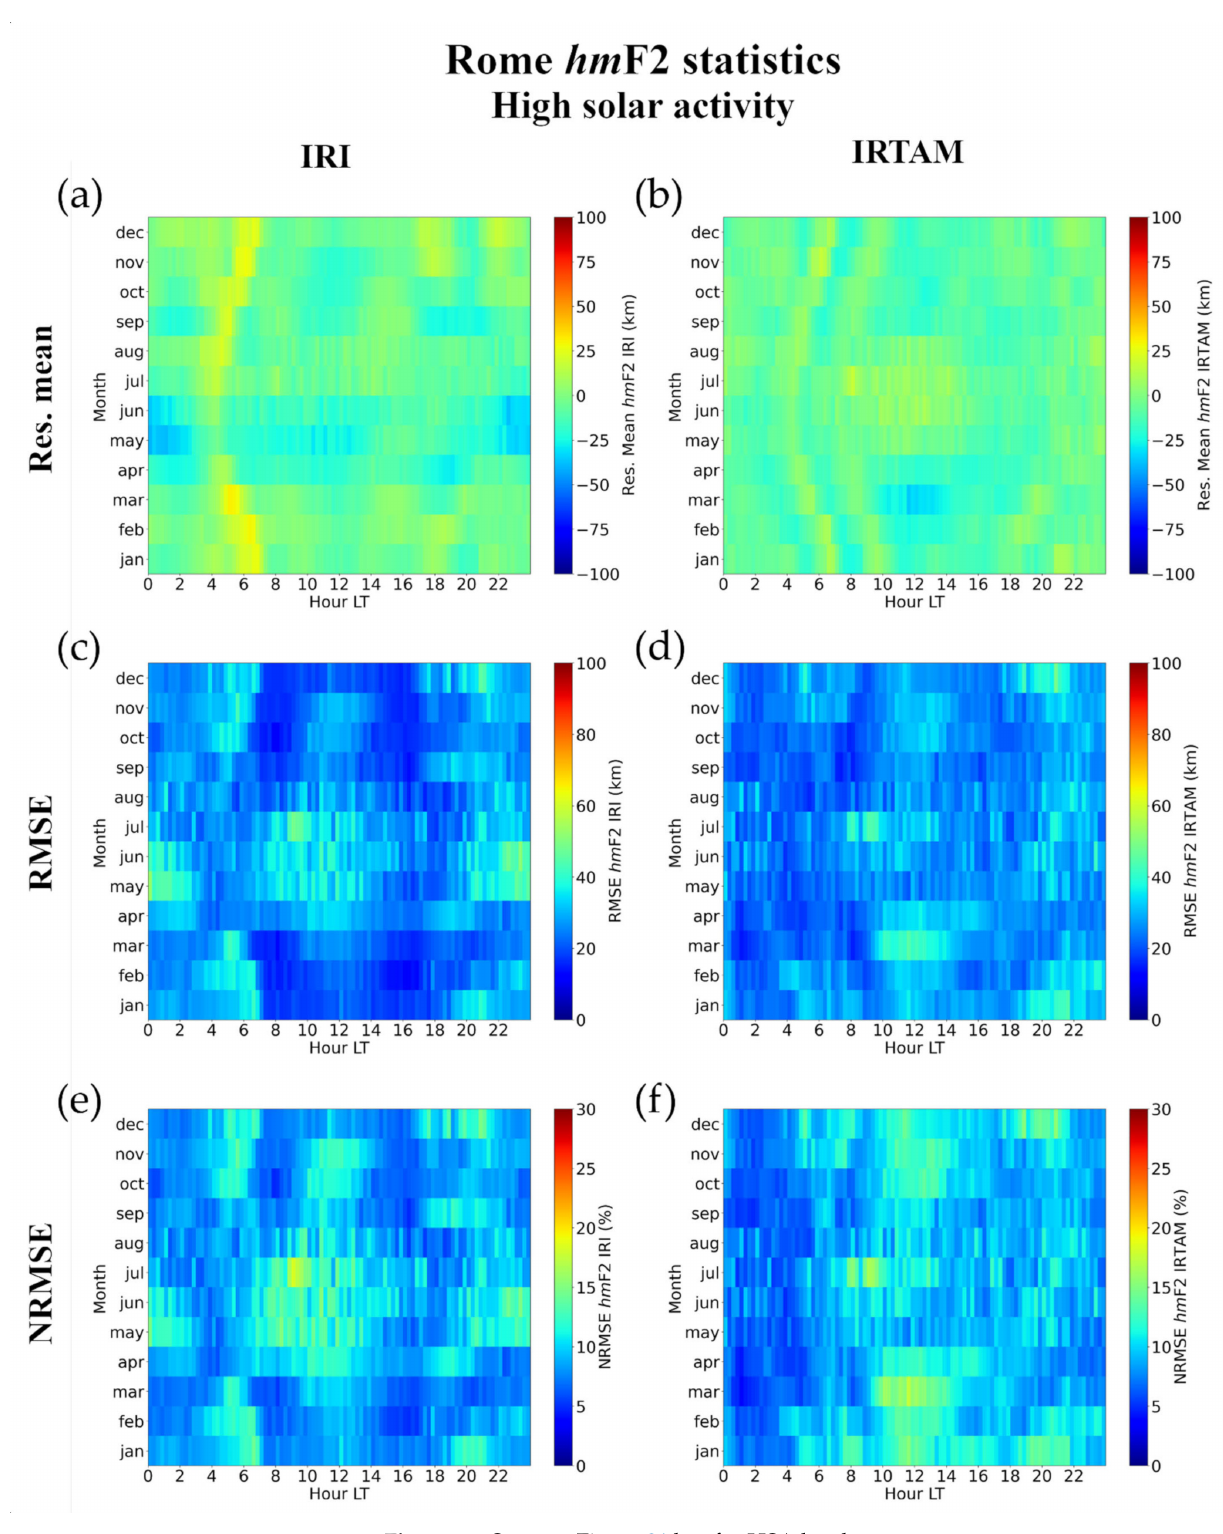
Figure 33. Same as Figure 31 but for HSA